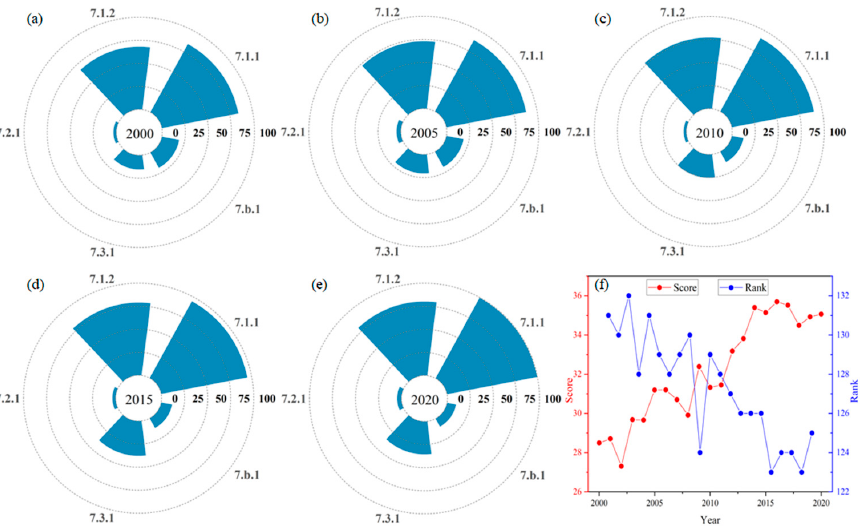
Figure 7. The scores of SDG7.1.1, SDG7.1.2, SDG7.2.1, SDG7.3.1 and SDG7.b.1 in the ASB, 2000–2020